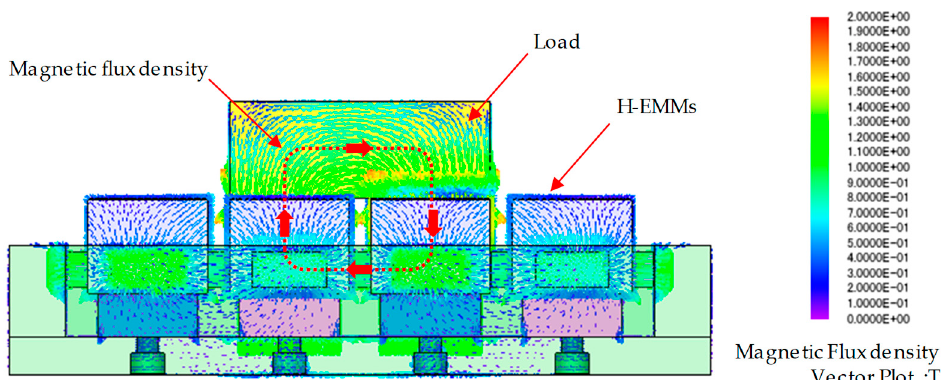
Figure 7. Magnetic flux density of the H-EMMs in attachment mode.